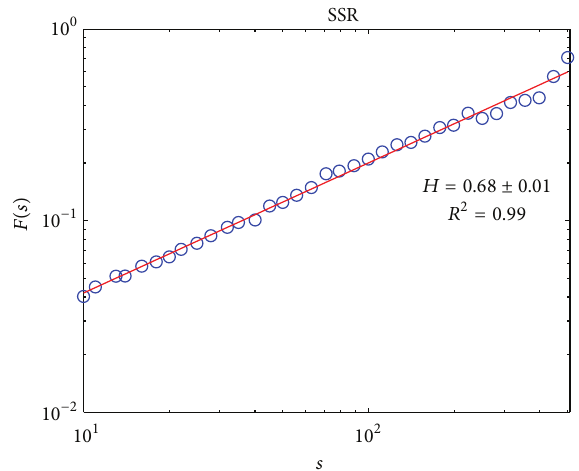
Figure 10: The DFA function of the single-step survival ratio (SSR) on a log-log plot. The red solid line stands for the associated linear fitting curve, and the estimated Hurst exponent 𝐻 and its corresponding coefficient of determination 𝑅 2 are presented.